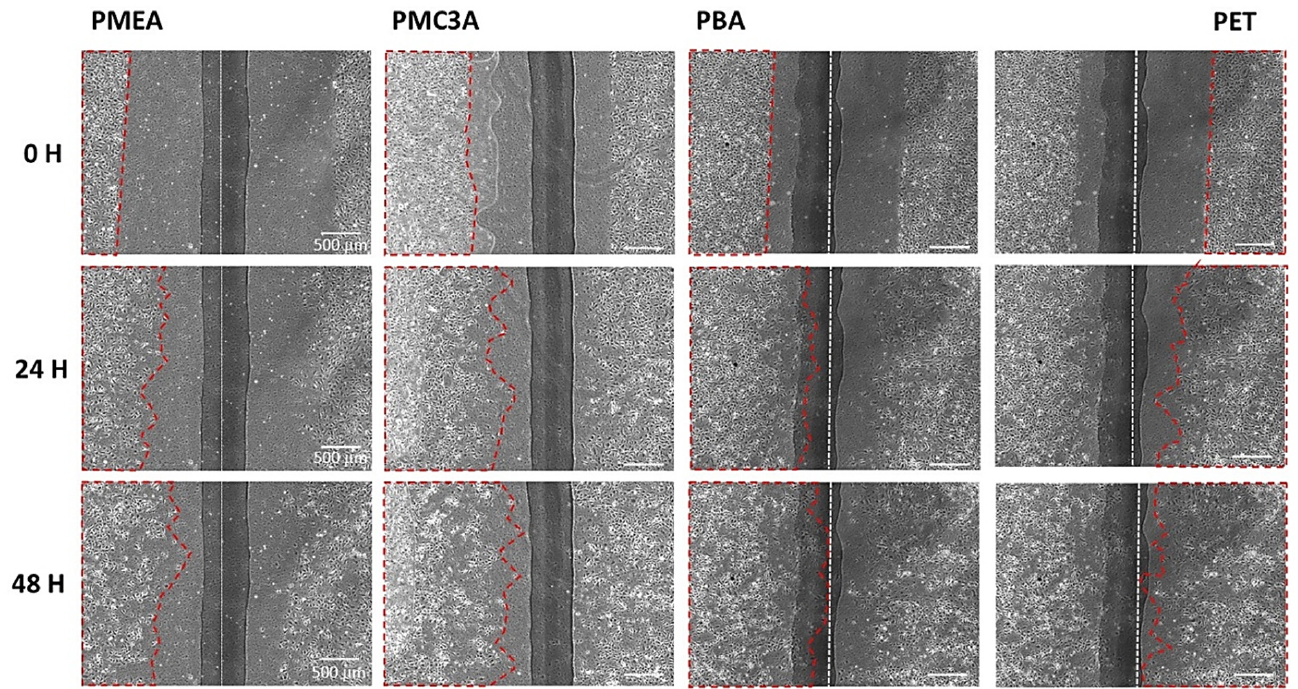
Figure 6. HUVECs migration analysis on PMEA, PMC3A, PBA, and PET (scale bar = 500 μ m). The white dotted line indicates the interface between PMEA-analogous polymers and bare PET. Migration was recorded from 0 to 48 h. The red dotted line indicates the HUVECs occupied area before and after migration.